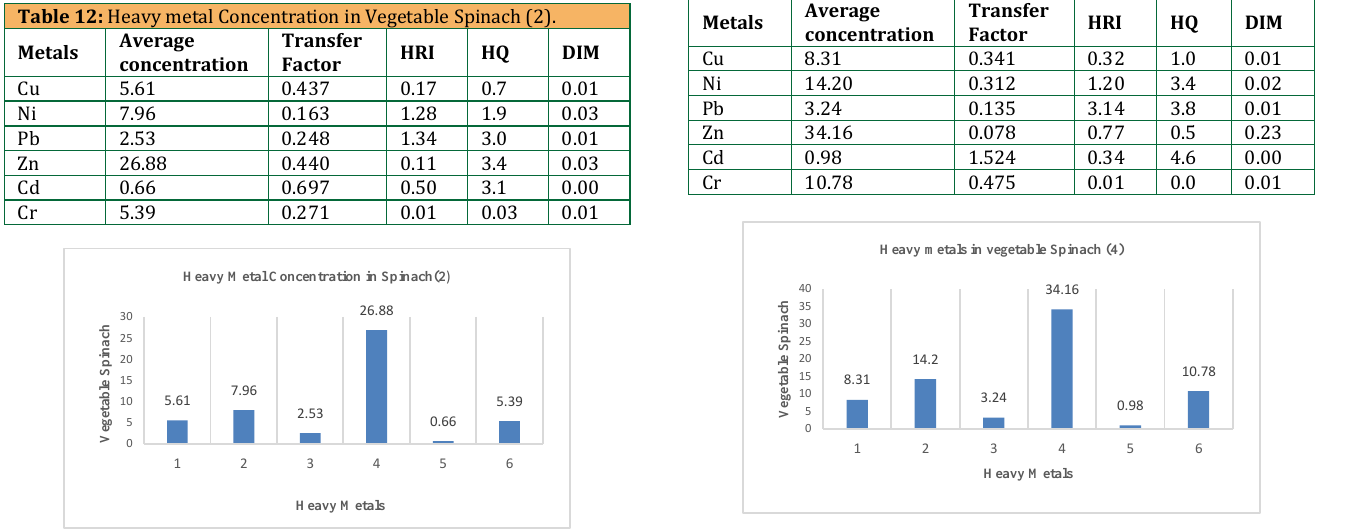
Figure 11: Average Concentration in vegetable Spinach